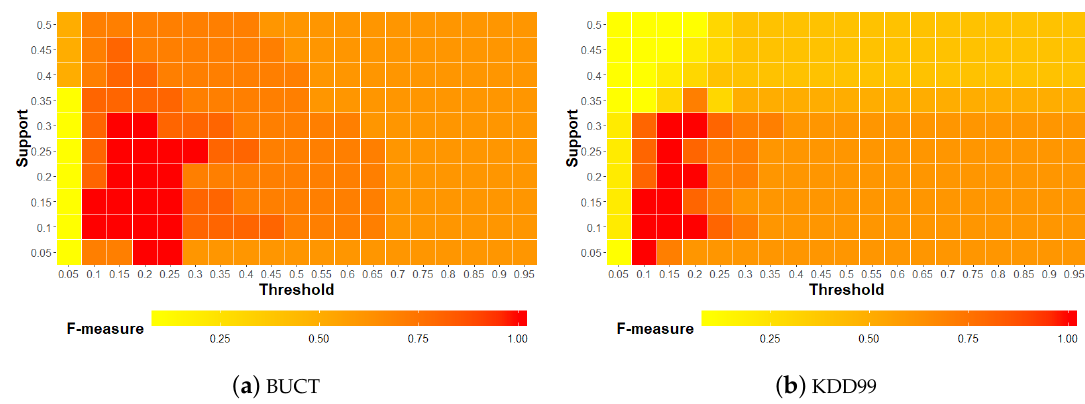
Figure 8. F-measure with different support and threshold network anomaly